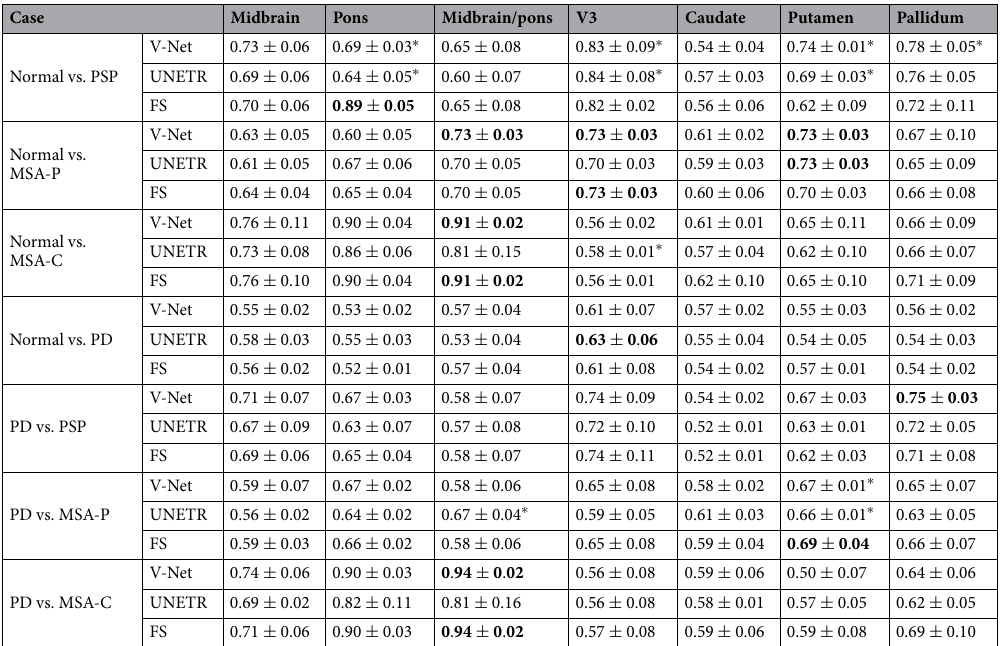
Table 2. Disease binary classification based on individual brain structures. Segmentation AUC of CNN-based V-Net, ViT-based UNETR, and FS. Mean ± standard deviation for threefold cross-validation and midbrain-to- pons ratio segmentation are listed. * p < 0.05 indicates a significant difference in AUC between the DL models and FS. The best result for each volume segmentation method based on FS and DL in binary classification is shown in